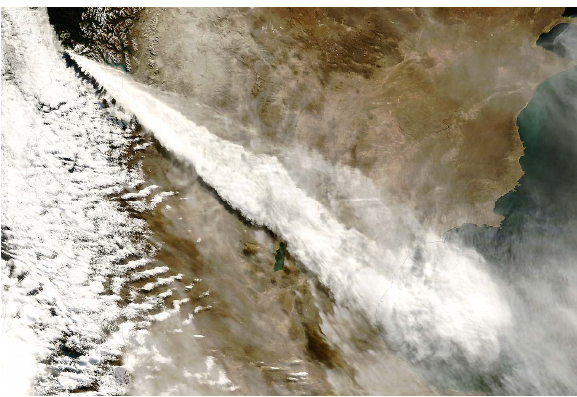
Fig. 12. (B) Satellite view of the first ashcloud from the eruption of Chaitén Volcano, Fig. 12b. Satellite view of the first ashcloud from the eruption southern Chile, drifting downwind across Argentina and dissipating over the of Chait´en Volcano, southern Chile, drifting downwind across Ar- gentina and dissipating over the Atlantic Ocean (MODIS/NASA Atlantic Ocean [MODIS/NASA image, 3 May 2008.]. image, 3 May